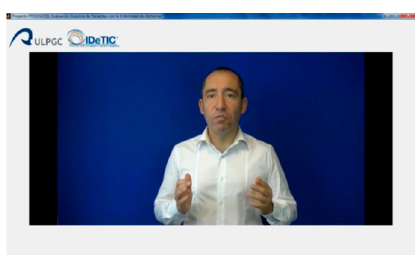
Figure 6. Frame of the video explaining the process. Instructions.